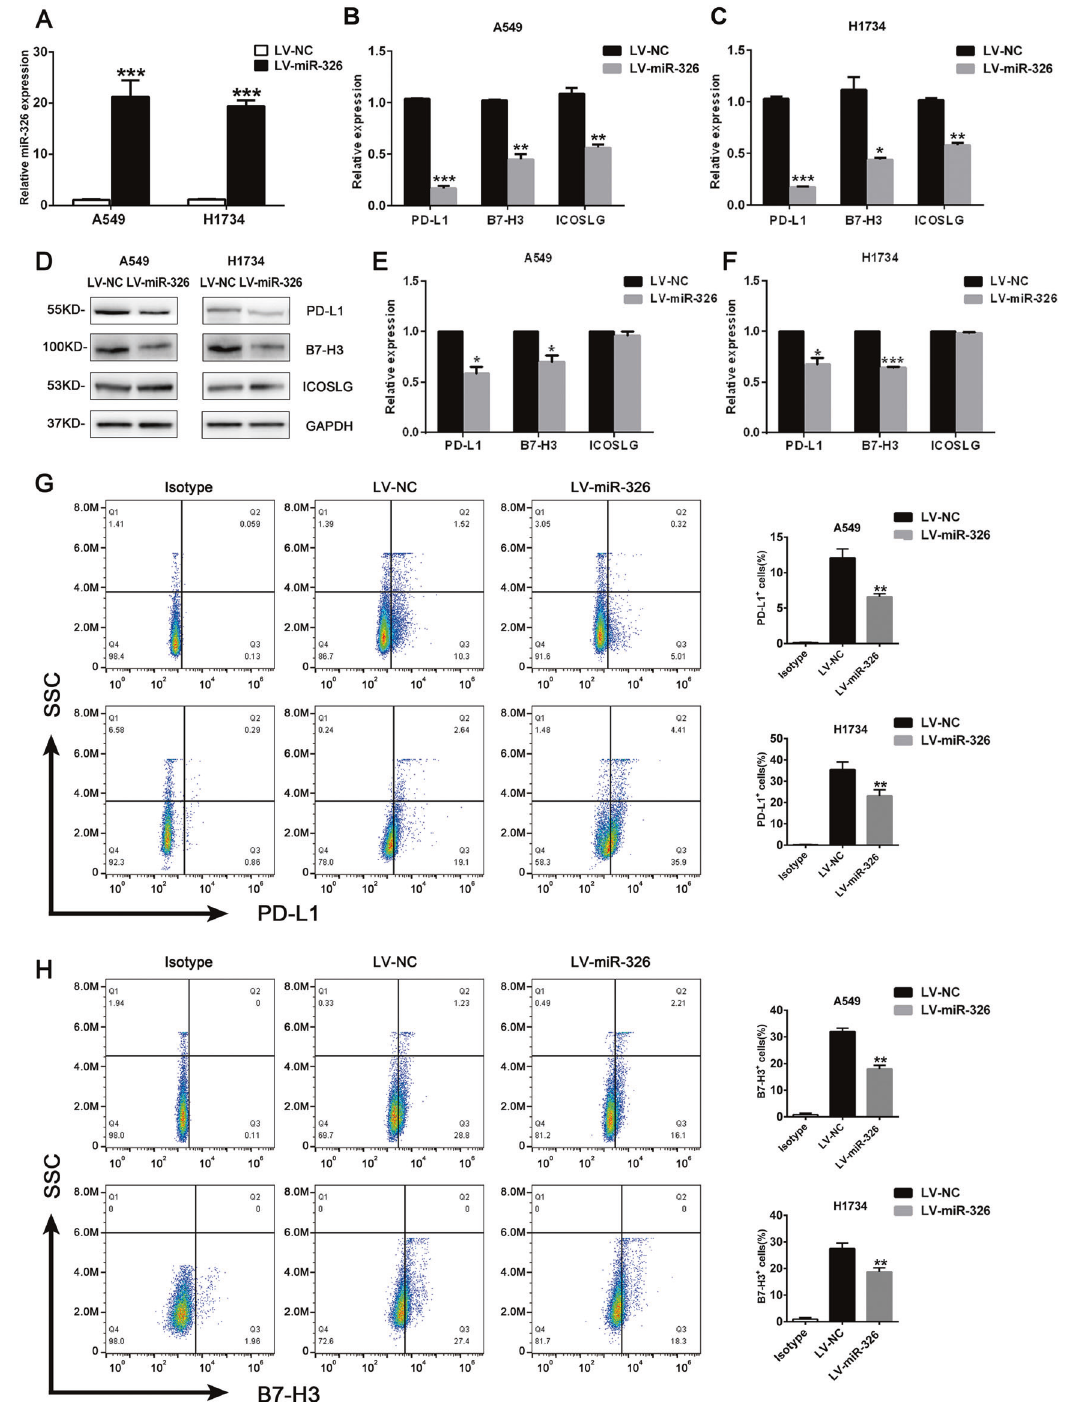
Fig. 3 MiR-326 repressed PD-L1 and B7-H3 expression in LUAD cells. Lentivirus was used to overexpress miR-326 in A549 and H1734 cells. A Relative expression of miR-326 72 h after lentivirus infection was quanti fi ed by qRT-PCR ( n = 3). B , C Relative expression of PD-L1/B7-H3 in miR-326 overexpressed A549 cells and H1734 cells was quanti fi ed by qRT-PCR ( n = 3). D Protein levels of PD-L1 and B7-H3 after miR-326 overexpression were determined by western blots. E , F Statistical histogram of the western blots ( n = 3). PD-L1 ( G ) and B7-H3 ( H ) expression on tumor cells was detected by fl ow cytometry ( n = 3). All data were presented as mean ± SEM. Comparisons between groups for statistical signi fi cance were performed with Student ’ s t test. * P < 0.05, ** P < 0.01, *** P < 0.001 versus